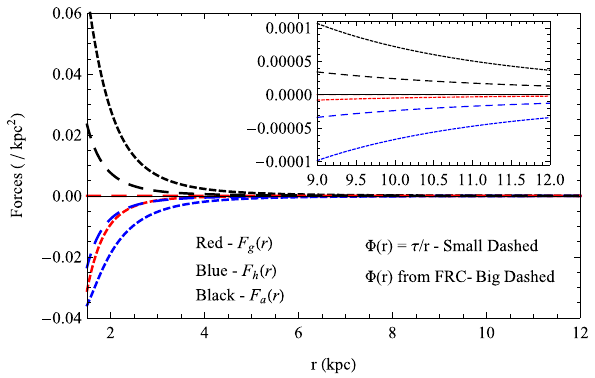
Fig. 17 Three forces are plotted with respect to the radial coordinate r corresponding to the parameters η = 0 . 003 , ρ 0 = 0 . 004 kpc − 2 , α = 0 . 5 , β = 0 . 8 , r th = 1 kpc , r 0 = 2 kpc along with τ = 2 . 5 and C = 0 . 05 , j = 1 , k = 1 , δ = 0 . 1 , γ = 0 . 001,